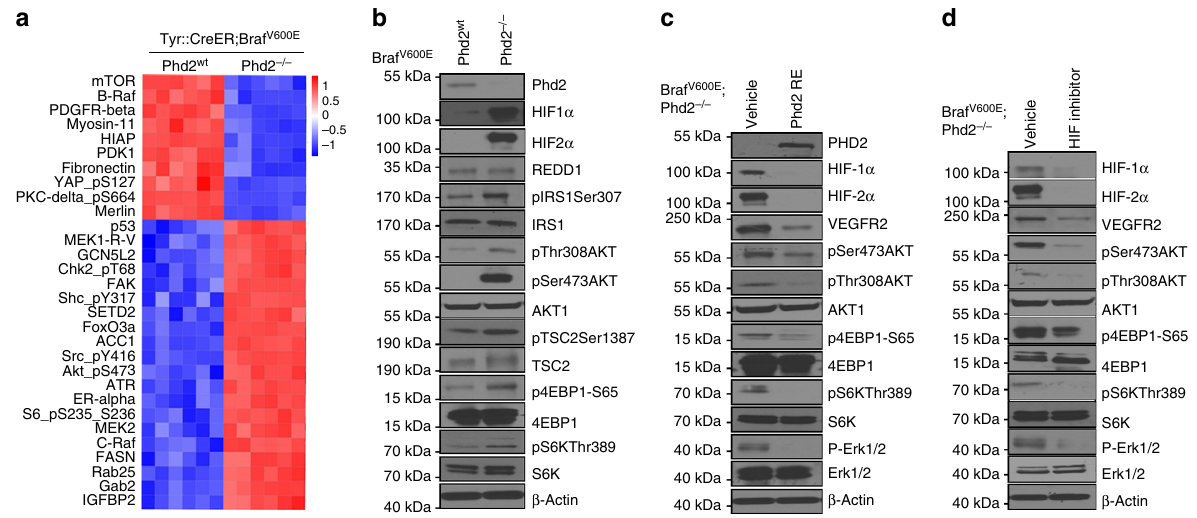
Fig. 6 Phd2 deletion leads to activation of the Akt – mTOR pathway. a RPPA analysis of tumors with homozygous deletion of Phd2 . Tumor tissues from Tyr:: CreER ; BRaf V600E ; Phd2 − / − or Tyr::CreER ; BRaf V600E mice were processed and analyzed by RPPA assays. The analyses identi fi ed proteins that were signi fi cantly changed in mouse melanomas compared to nevi . b Activation of Akt – mTOR pathway after phd2 deletion. Tumor tissues were processed and western blots showed stabilization of HIF-1 α and HIF-2 α proteins after Phd2 depletion. Increased phosphorylation of Akt, 4EBP1 and S6K was observed in tumors from Tyr::CreER ; BRaf V600E ; Phd2 − / − compared with those of Tyr::CreER ; BRaf V600E mice. c Re-expression of Phd2 inhibits the Akt – mTOR